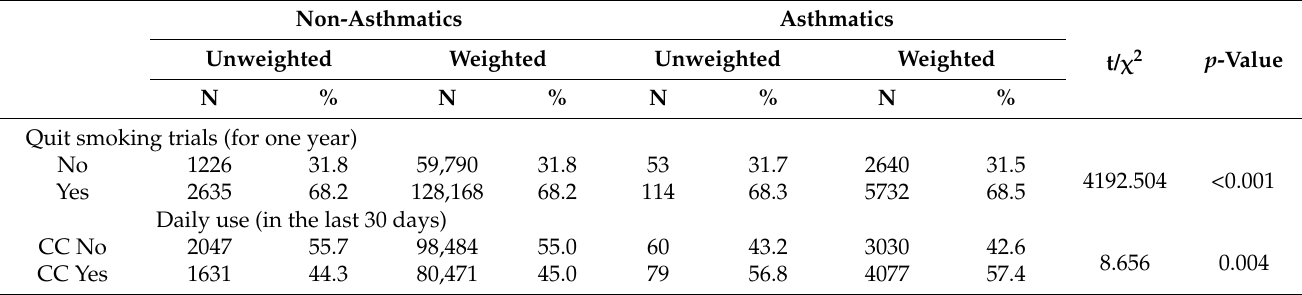
Table 2. Difference in smoking behaviors by asthma